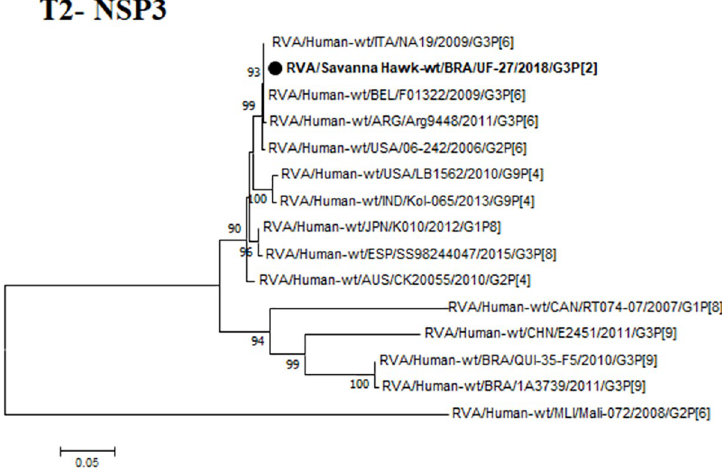
Fig 2. Phylogenetic tree based on the alignment of RVA NSP3 gene sequences. The sequence of this study is represents in bold, and the black color depicts the birds. The numbers next to the nodes indicate bootstrap values > 70.